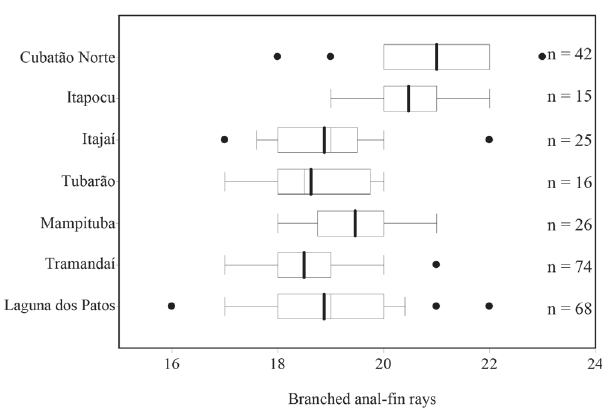
Fig. 11. Tukey box plots of number of branched anal-fin rays in Astyanax laticeps populations by river drainages from south to north. Mean represented by thick vertical bar, and 25 th and 75 th percetiles as lateral borders of box